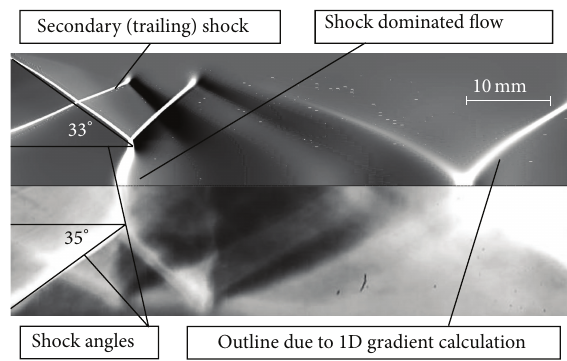
Figure 15: Comparison of ED schlieren images in the OX flow con-